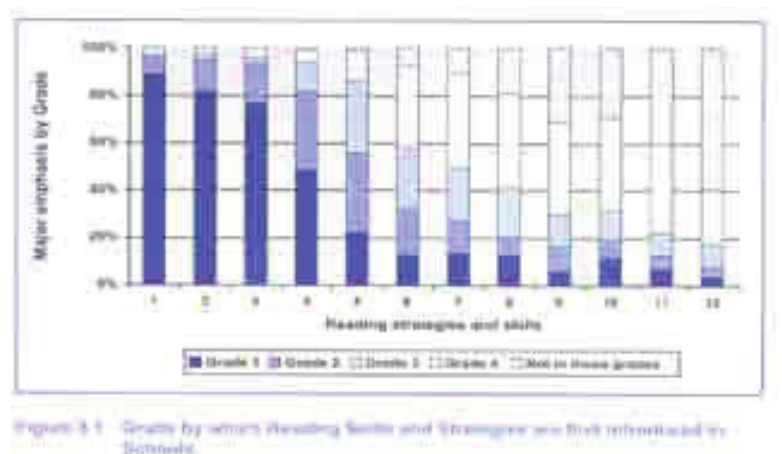
Figure 8.1: in Howie et al’s (2006) summary report shows the grade at which these strategies are first introduced in